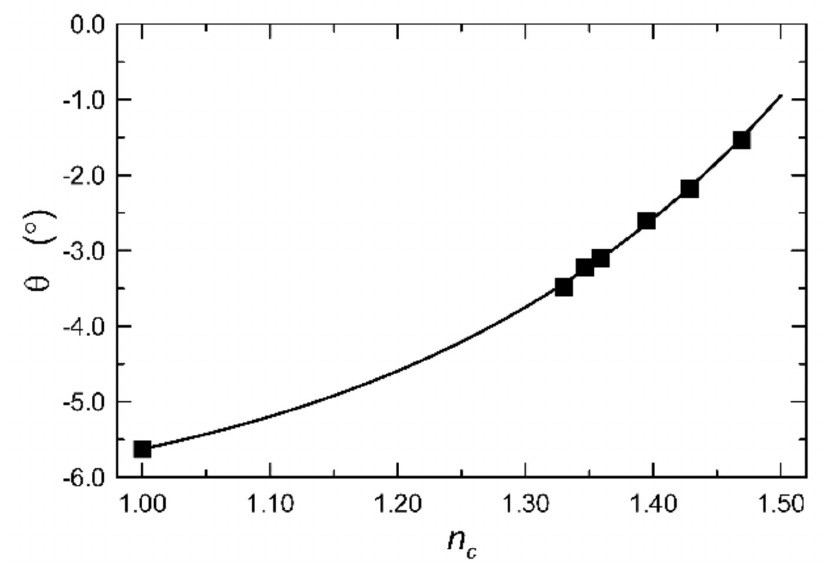
Figure 14. Experimental and theoretical characteristics of the in-coupling angles of the TM 0 mode with respect to a refractive index of the cover. The remaining parameters have the following values: χ = 2400 g/mm, λ = 676.7 nm, n 1 = 1.9102, d = 151.3